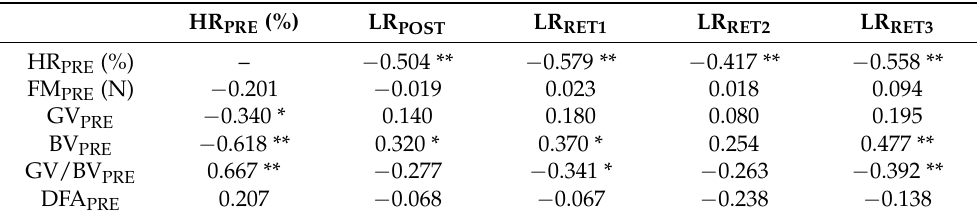
Figure 5. Pair comparisons results between the groups with different initial levels of GV/BV. ( A ) the Hit ratio values; ( B ) refers to the Good and Bad variability ratio; ( C ) refers to Good Variability values; and ( D ) refers to Bad Variability values. * = significant differences between groups; a = significant differences compared with the pretest; b = significant differences compared with the posttest; c = significant differences compared with Retest1. Table 2. Pearson product moment correlation coefficient calculated between initial performance (HRPRE), the learning ratio, and the initial outcomes of the rest of the